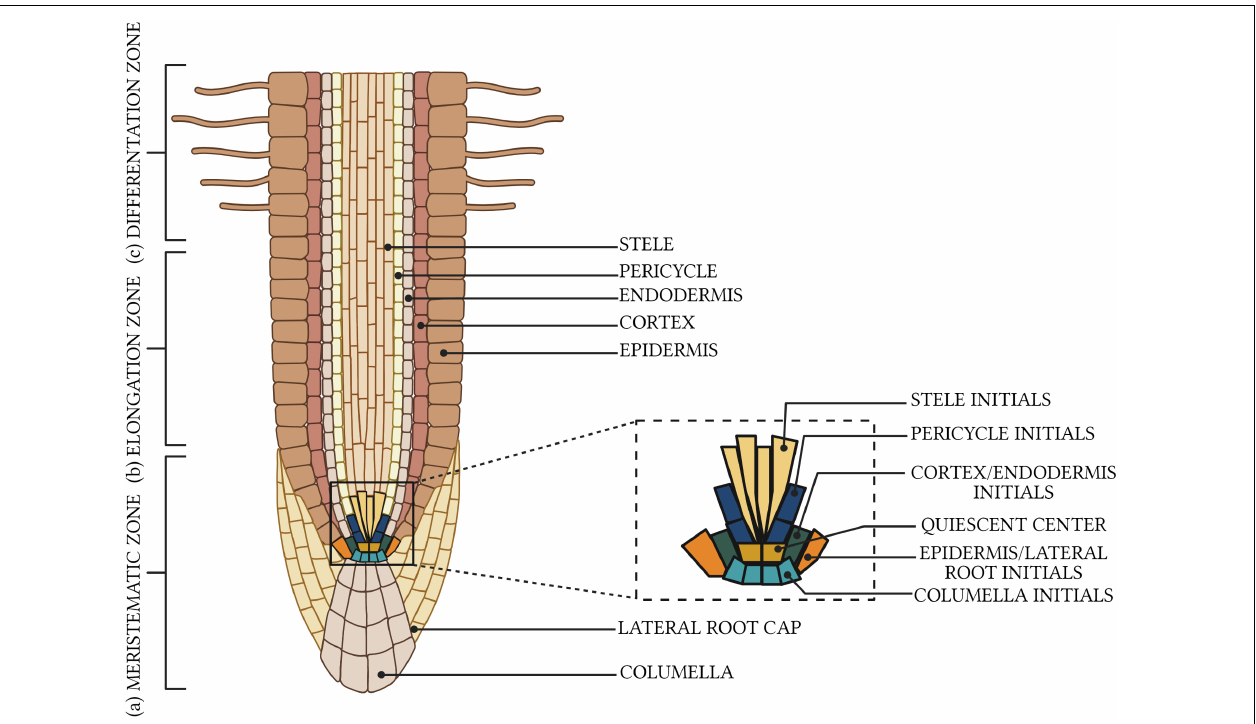
FIGURE 1 | Organization of plant root meristem. There are three distinct developmental zones: (a) meristematic with visible the quiescent center and initial cells in a stem cell niche, (b) elongation, and (c) differentiation. Created with